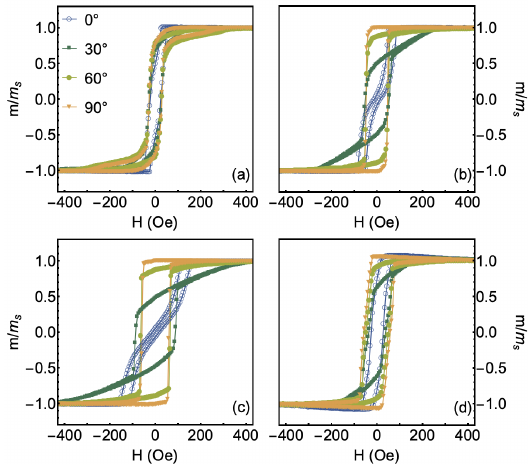
Figure 3. Normalized magnetization curves for the Co 2 FeAl/W bilayers grown onto GaAs (100) substrate, in which the CFA layer was deposited at the temperatures of ( a ) 300 K, ( b ) 573 K, ( c ) 673 K, and ( d ) 773 K. Here we present just the curves measured for ϕ = 0 ◦ , 30 ◦ , 60 ◦ and 90 ◦ . All the samples of the set present uniaxial magnetic anisotropy combined with cubic magnetic anisotropy, although these features are more evident for the ones produced at the temperatures of 573 K and 673